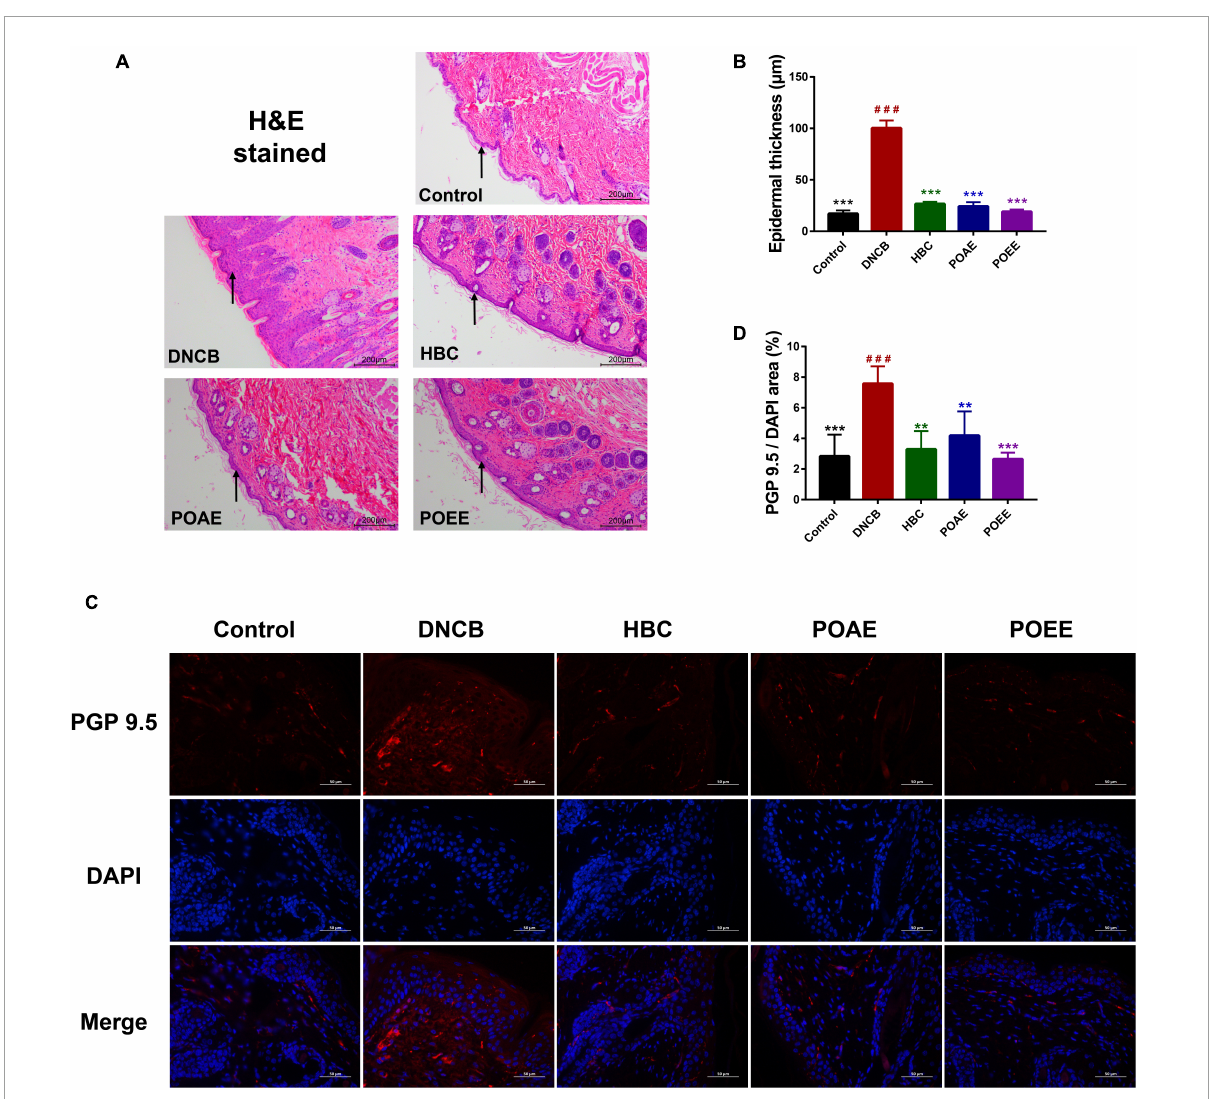
FIGURE3 POAE and POEE reduced the density of nerve fibers in the dorsal skin. (A) Representative photographs of H&E staining of the dorsal skin of each group of mice (Scale bar: 200 µ m). The black arrow indicates the epidermal layer of the skin. (B) Thickness of the epidermal layer of the dorsal skin of each group of mice ( n = 3 per group). (C) Immunofluorescence staining of representative dorsal skin nerve fibers from each group of mice (Scale bar: 50 µ m). The nuclei showed blue fluorescence after DAPI staining, and PGP9.5 showed red fluorescence under the labeling of fluorescent secondary antibody. (D) The ratio of PGP9.5/DAPI fluorescence area in each group of mice ( n = 4 per group). The data were expressed as mean ± SD. ### P < 0.001, vs. control groups; ** P < 0.01, *** P < 0.001, vs. DNCB (model)